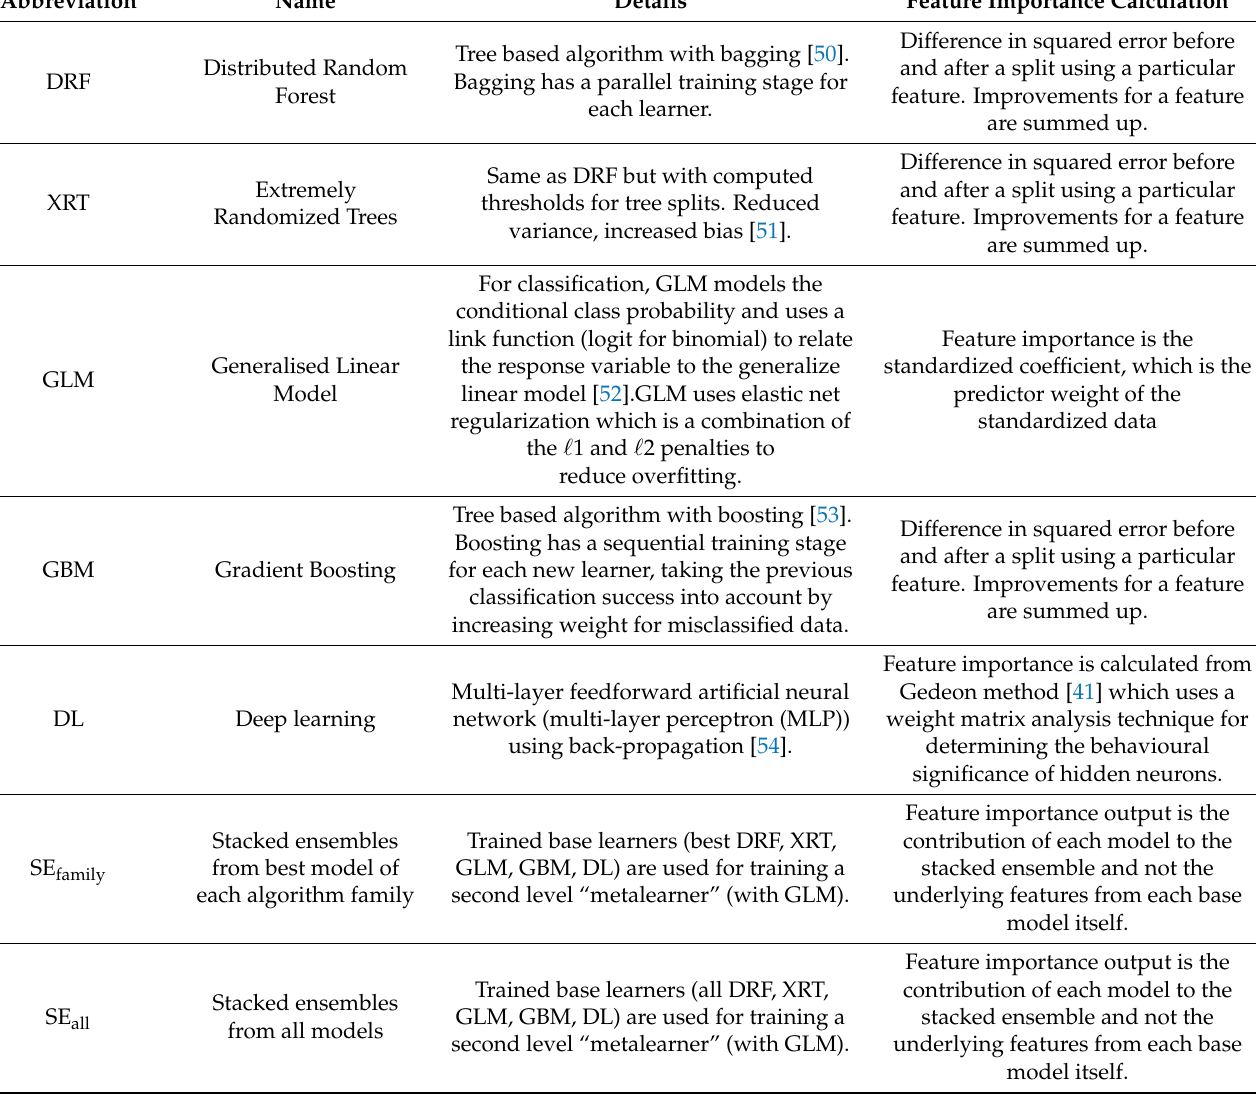
Table A2. Machine Learning algorithms used by H20.